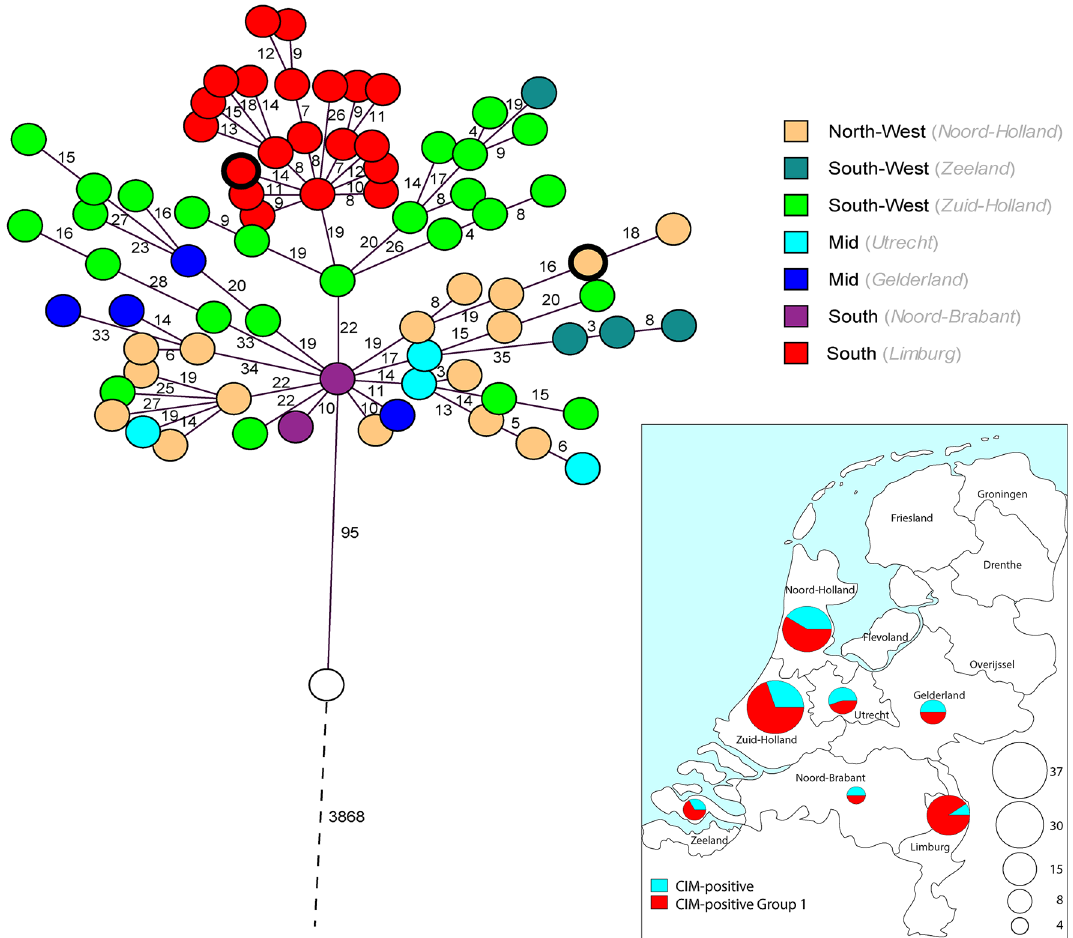
Figure 2. Geographical distribution of Group 1 isolates in the Netherlands. Above, Minimum-spanning tree of Group 1 isolates based on wgMLST analysis. Each circle represents an isolate. Colors indicate the region where the isolate was obtained. Dutch provinces are given in italics. The red circle with a thick border represents the CIM-positive Group 1 isolate that carried a bla IMP-13 gene. The beige circle with a thick border represents the CIM-negative Group 1 isolate. The white circle represents the CIM-negative ST111/O12 isolate most closely related to Group 1. For understanding distances between isolates, refer to Fig. 1. Below, Map of the Netherlands showing the distribution of 112 CIM-positive P. aeruginosa isolates that were sequenced in this study, and the number of those isolates that were Group 1, by province. Map was created by importing a screen capture into Adobe Illustrator 2020 and plotting the origin of isolates using the Type-Ned MRSA website (www. typen ed- mrsa. rivm.